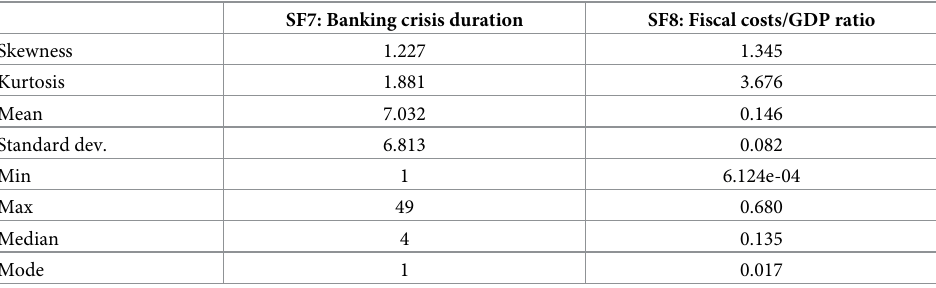
Table 4. Distribution related stylized facts.